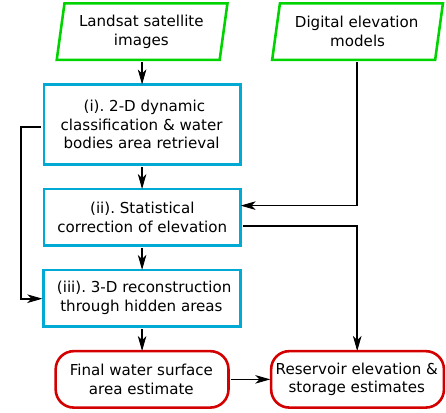
Figure 2. Flowchart of the whole